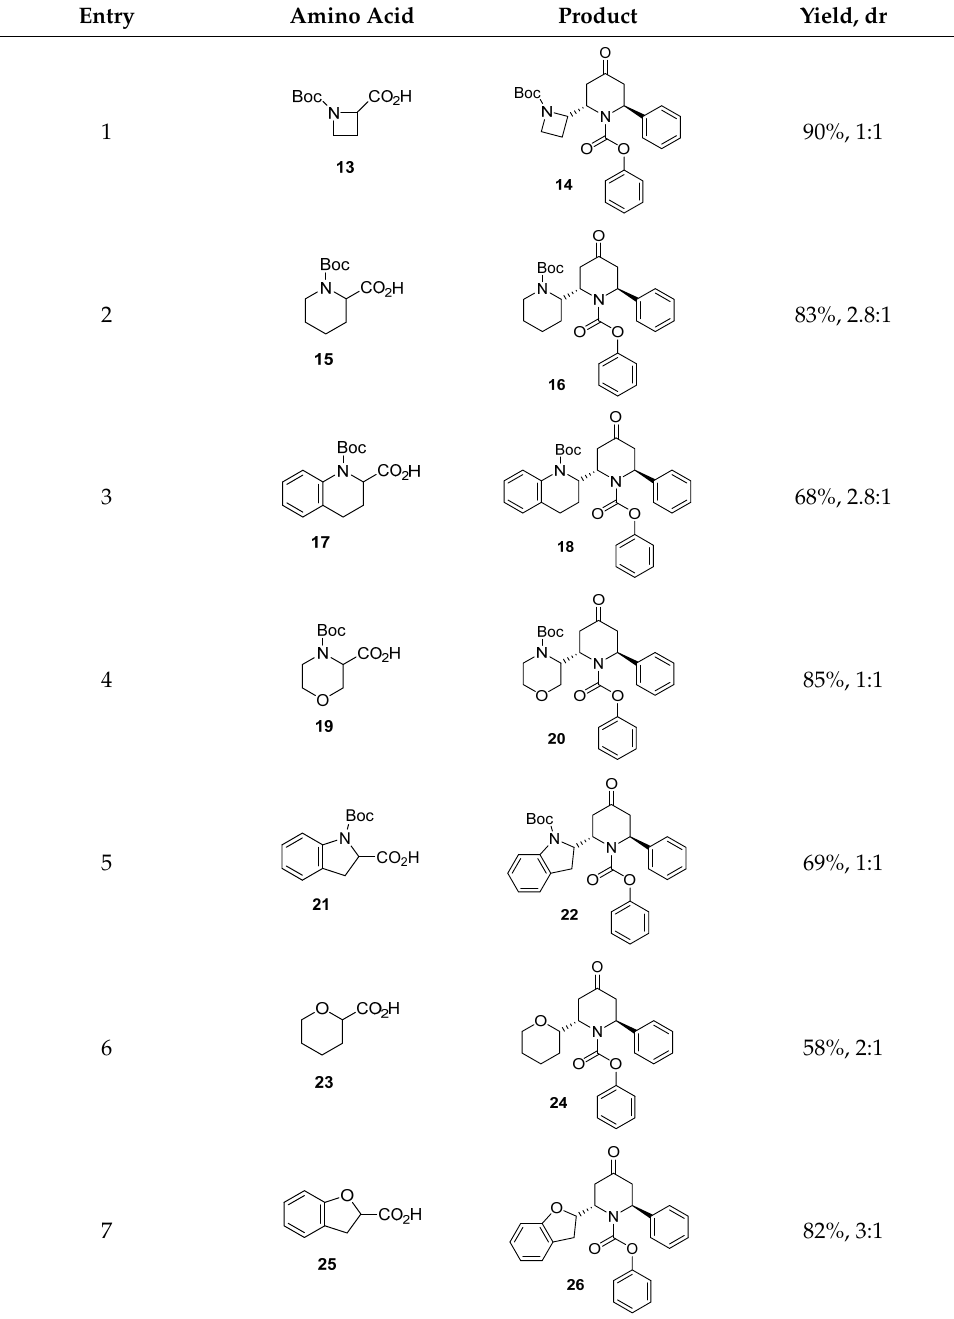
Table 1. Scope of amino acid additions to dihydropyridone 5 .